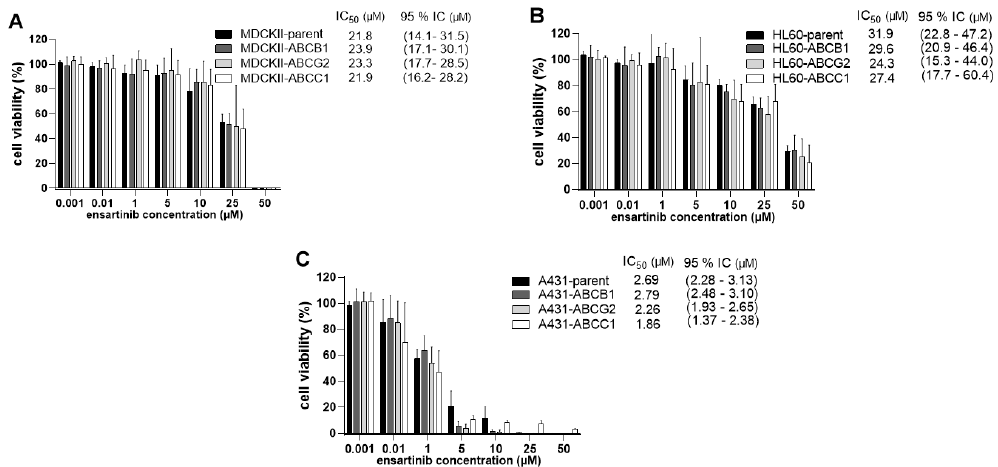
Figure 10. Sensitivity of MDCKII ( A ), HL60 ( B ), and A431 ( C ) sublines to ensartinib. The cells were treated with ensartinib for 48 h and their viabilities were measured using the MTT (MDCKII, A431) or XTT (HL60) proliferation tests. One-way ANOVA followed by Dunnett’s post hoc test was used for statistical comparisons. The viabilities of the parent cells were compared to those of transporter-overexpressing cells for each concentration; no statistically significant differences were observed for any variant. Additionally, the IC 50 values of transduced and parent cells were compared using the two-tailed unpaired t -test. Again, no statistically significant differences were observed. The plotted values are means ± SD based on three independent experiments.